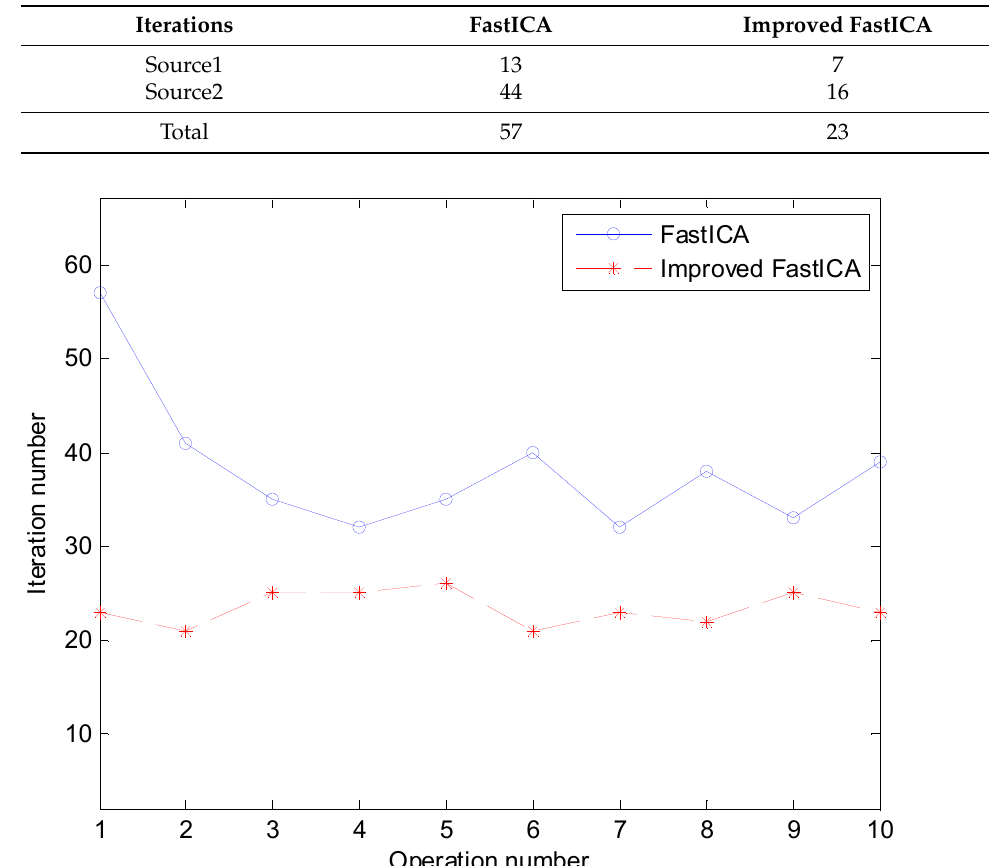
Table 4. The number of iterations corresponding to the separated two source signals in a certain run.